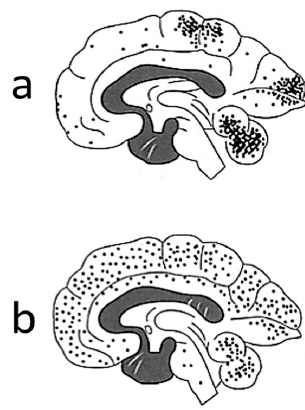
Figure 2. Comparisons of the distributions of lesions among adult and fetal-type cases of Minamata disease. Note: The distributions of degenerated neurons in adult ( a ) and fetal patients ( b ) are shown. (Modified from Reference [9] with permission).